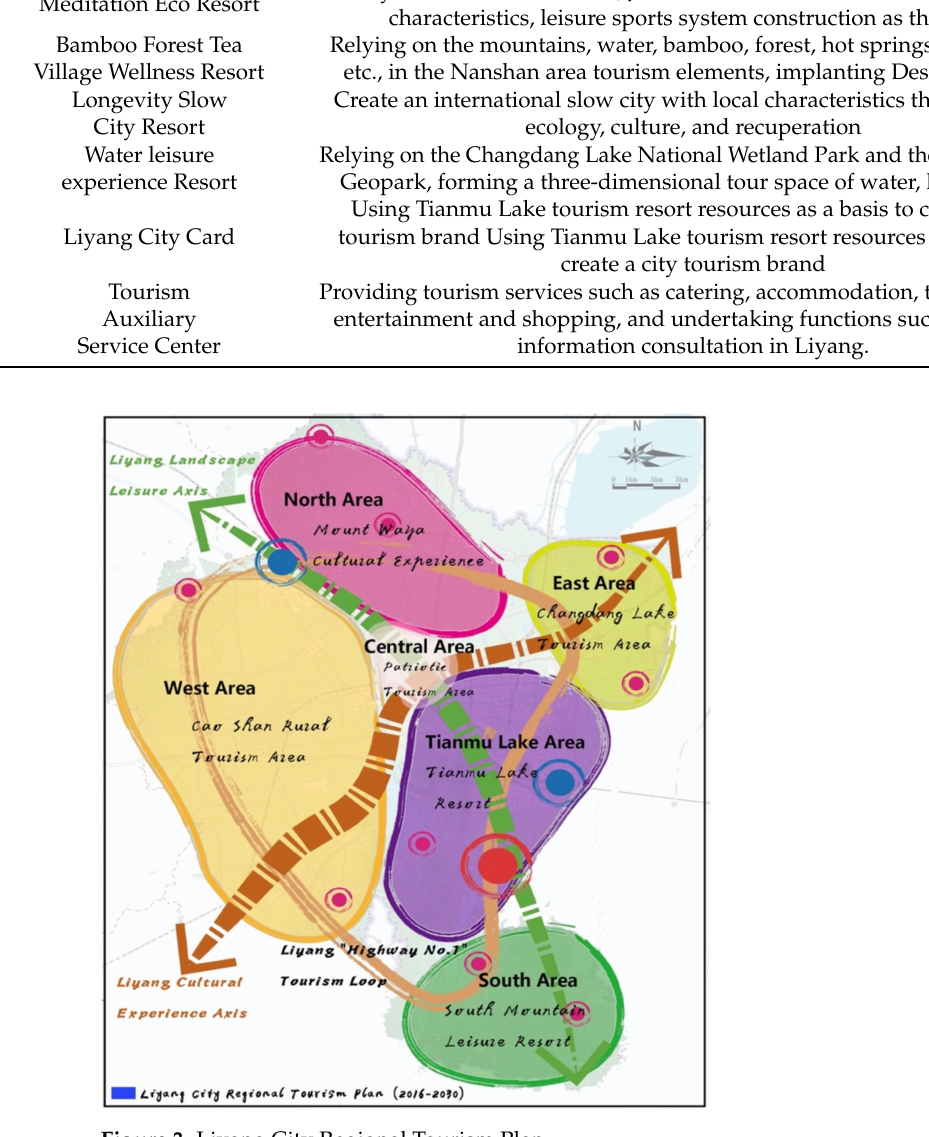
Figure 3. Liyang City Regional Tourism